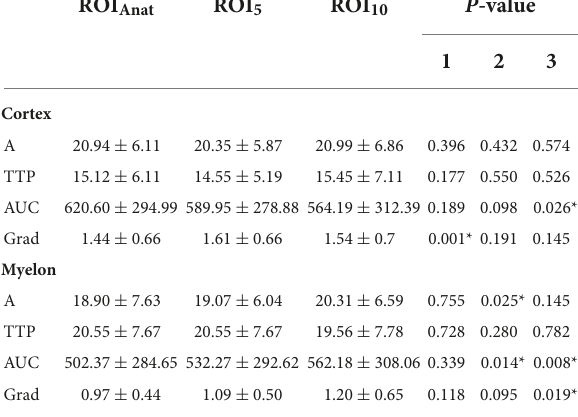
p-value group: 1 = ROI 5 vs. ROI Anat , 2 = ROI 5 vs. ROI 10 , and 3 = ROI 10 vs. ROI Anat (n=33).A,AUC,Gradina.u.;TTPinseconds. *p < 0.05.